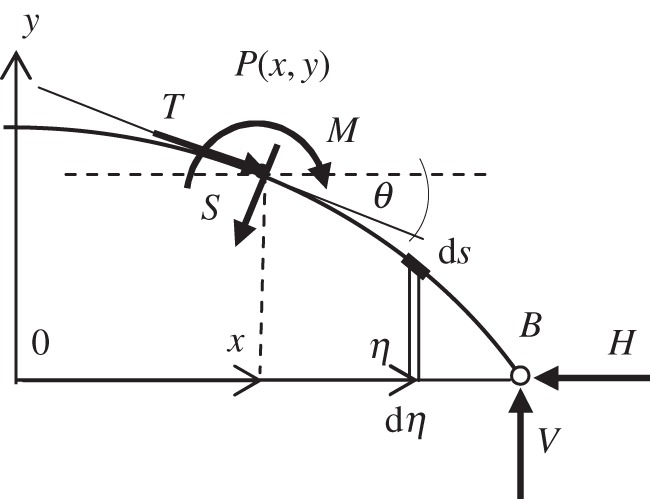
Forces acting on segment PB.